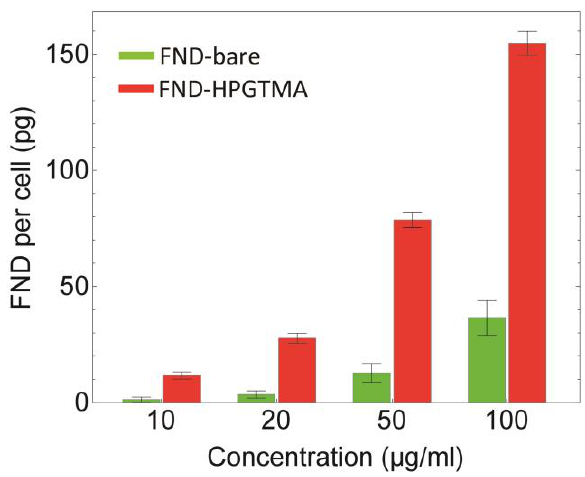
Figure 3. Concentration-dependent labeling of HeLa cells with FND samples analyzed by magnetically modulated fluorescence. Values are means ± standard deviations of three measurements.